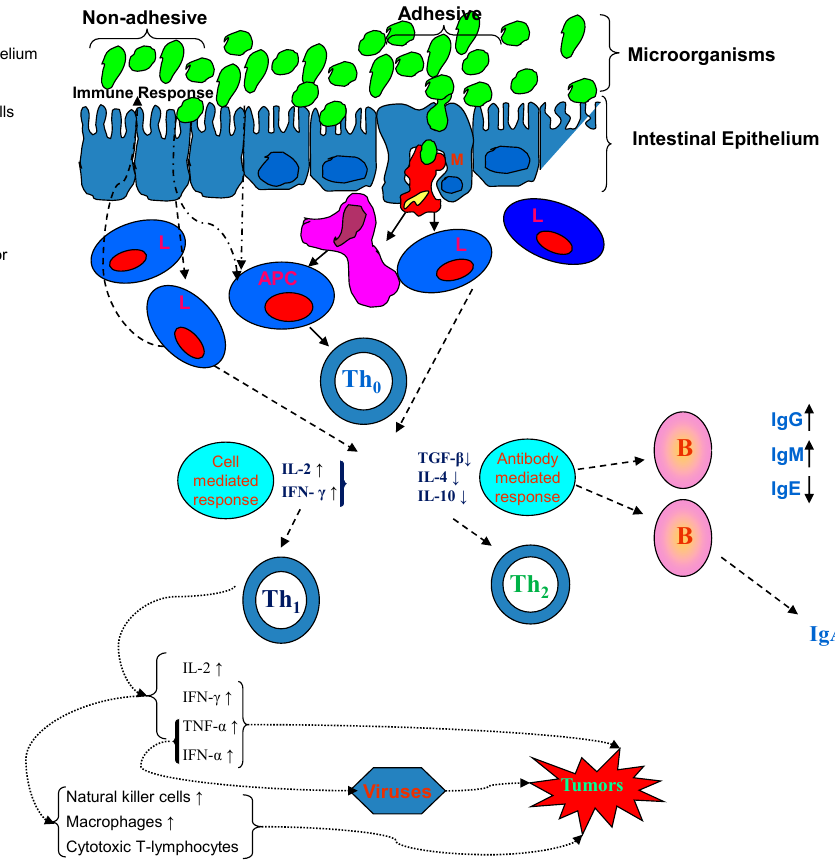
Figure 1. Modulating the gut microbiome: the microbiota maintains intestinal integrity with gut associated lymphatic tissue T cell activation and differentiation.